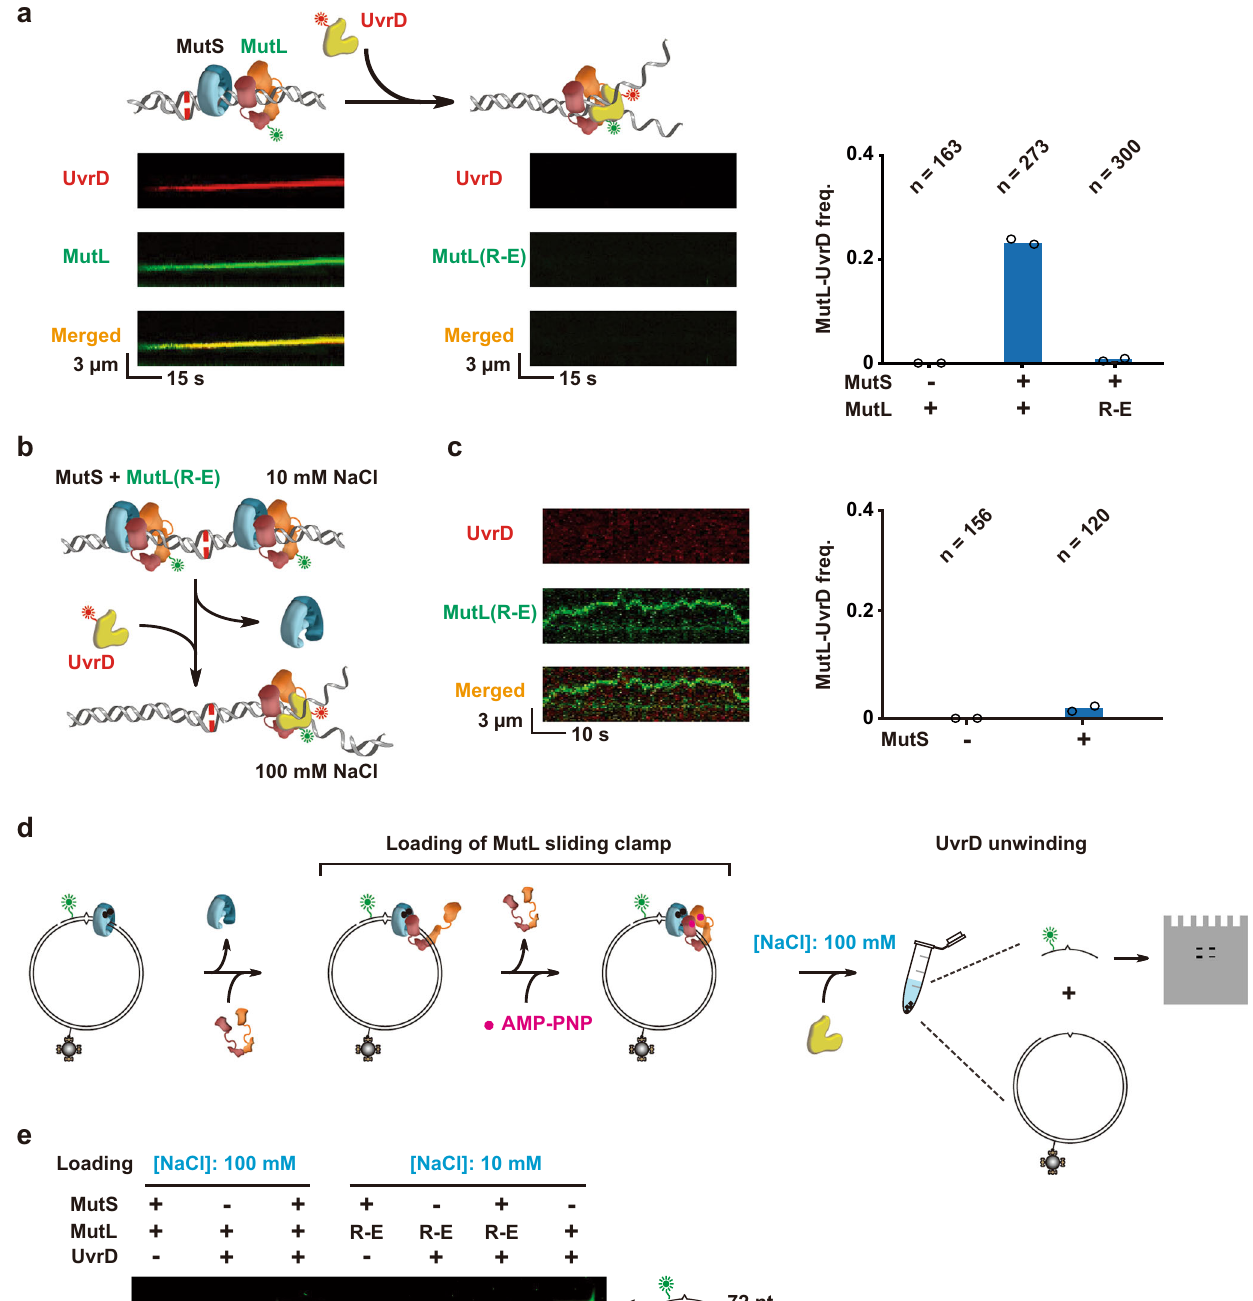
Fig. 7 | The MutL NTD positively charged cleft enhances capture of the UvrD helicase. a Left: Illustration (top) and representative kymographs (bottom) showing a Cy3-MutL sliding clamp loaded by an unlabeled MutS sliding clamp (color-coded as described in Fig. 2b) interacting with a Cy5-UvrD helicase (yellow), while no interaction was detected between Cy3-MutL(R-E) and Cy5- UvrD under physiological ionic conditions (~120mM). Right: The frequency of Cy3-MutL/Cy5-UvrD complex formation at physiological ionic conditions (~120mM; n =total number of DNA molecules examined). b An illustration showing the loading of Cy3-MutL(R-E) by MutS at very low ionic strength (~30mM), followed by buffer exchange to observe the interaction between a Cy3-MutL(R-E) sliding clamp with Cy5-UvrD. MutS, MutL and UvrD are color-